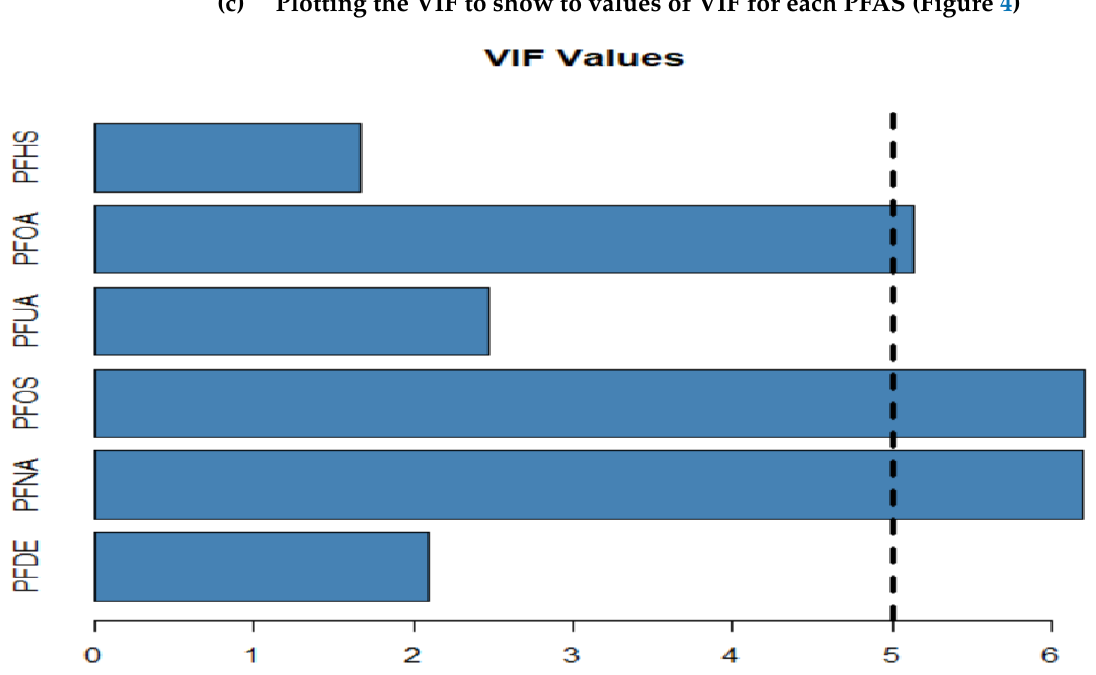
Figure 4. The variance inflation factor (VIF) values for selected PFAS.